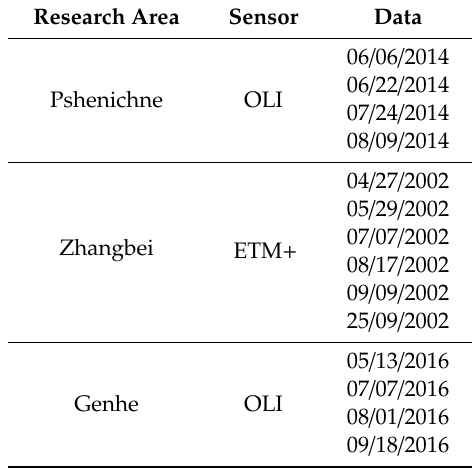
Table 1. List of Landsat data used in this study.